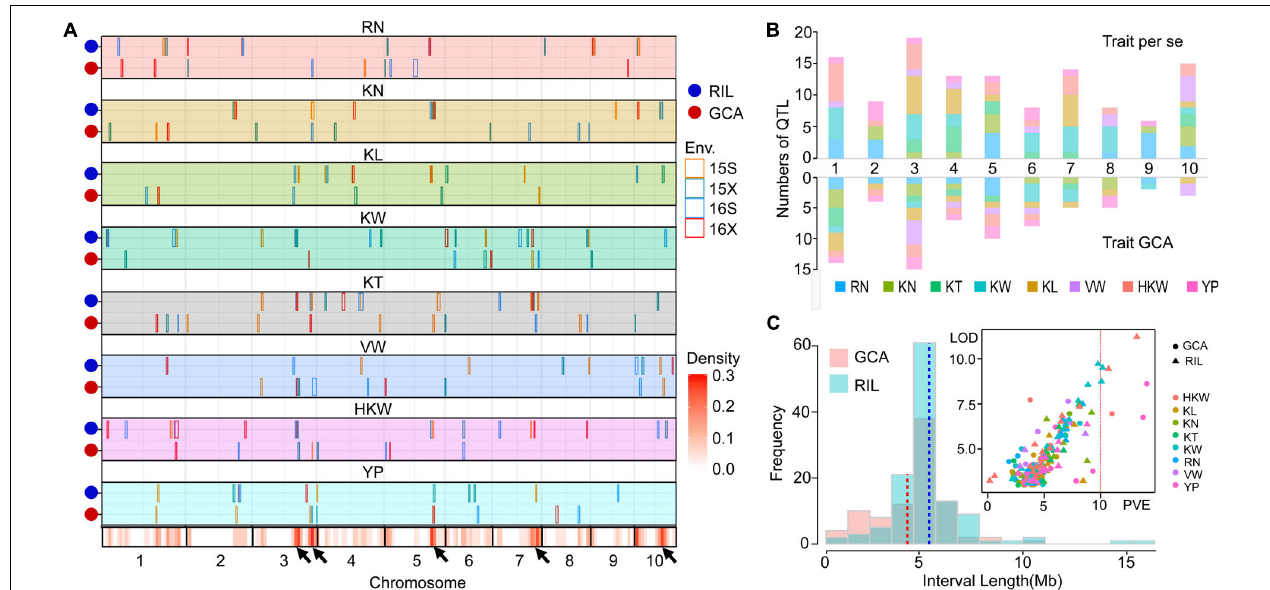
FIGURE 2 | Chromosomal distributions of yield-related QTL identified in the present study. (A) QTL regions represented by the confidence intervals for linkage mapping across the maize genome from each dataset are shown as boxes. The width of the boxes reflects the length of the confidence interval. The different colors of the boxes indicate the four environments, respectively. Orange , 2015 Shijiazhuang; green , 2015 Xinxiang; blue , 2016 Shijiazhuang; and red , 2016 Xinxiang. The x -axis indicates genetic positions across the maize genome in Mb. The heatmap under the x -axis illustrates the density of grain yield-related related QTL across the genome. The black arrows point out the QTL hotspots. RN, Row number; KN, Kernel number per row; KT, Kernel thickness; KW, Kernel width; KL, Kernel length; HKW, 100-kernel weight; VW, Volume weight; YP, Yield per plot. (B) The numbers of QTL distributed on each chromosome for the eight yield-related traits identified for per se performances of traits (above) and their GCA effects (below). (C) Frequency distribution of QTL interval length and the variance explained by each QTL identified for per se performances of traits and their GCA effects. PVE, phenotypic variation